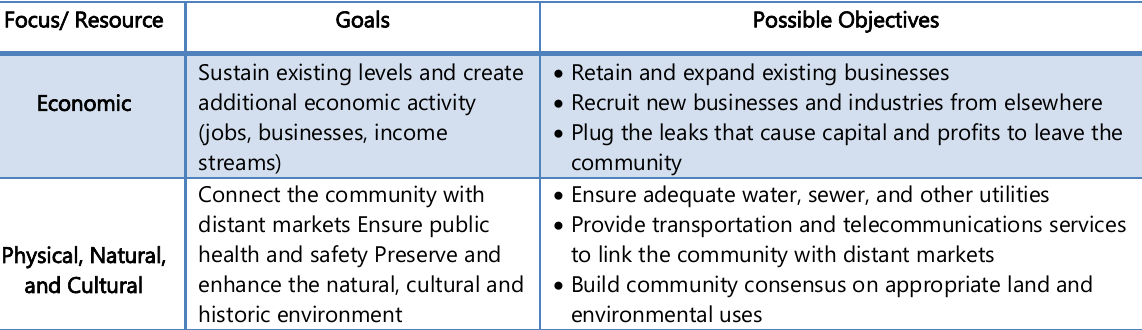
Table 1: Community Development Goals and Objectives (Source: Taylor 2009) Focus/ Resource